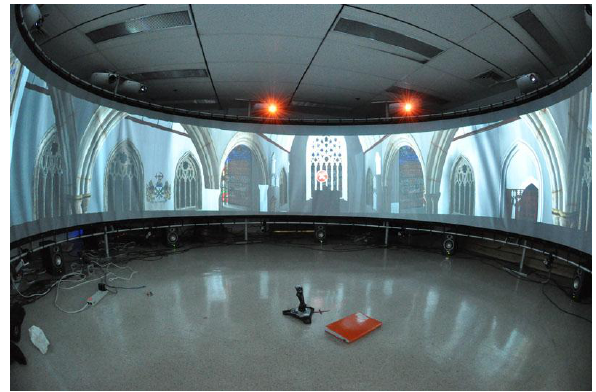
Figure 20 The screening of the 360º film on a 360º screen in Vision3D lab at the University of Montreal (Canada).